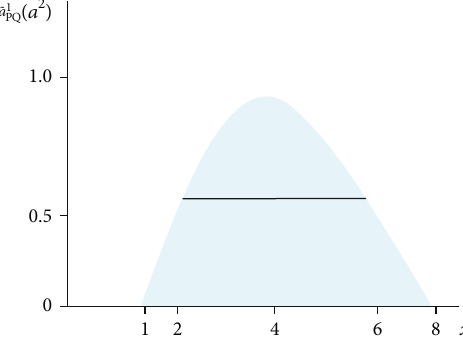
Figure 4: The membership function μ